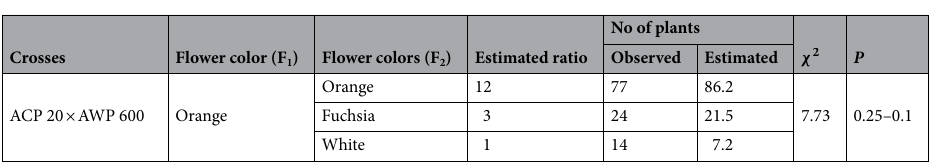
Table 2. Chi-square analysis for flower color in interspecific crosses P. sativum × P. fulvum.